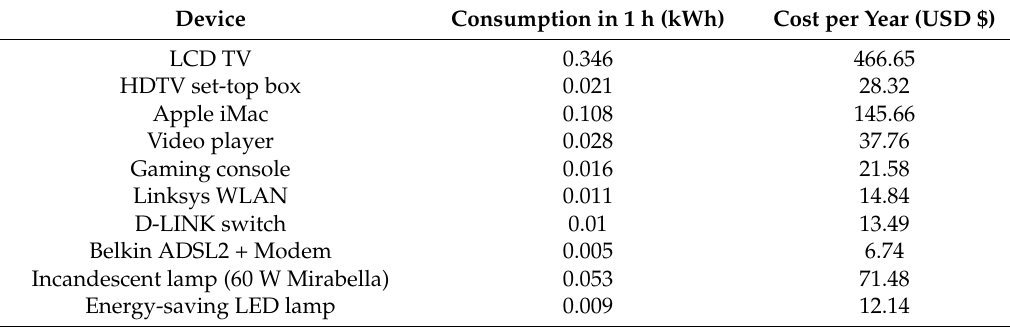
Table 3. Average household electronics power consumption and yearly cost. LCD: Liquid crystal display; HDTV: high-definition television; WLAN: wireless local area network; and ADSL: asymmetric digital subscriber